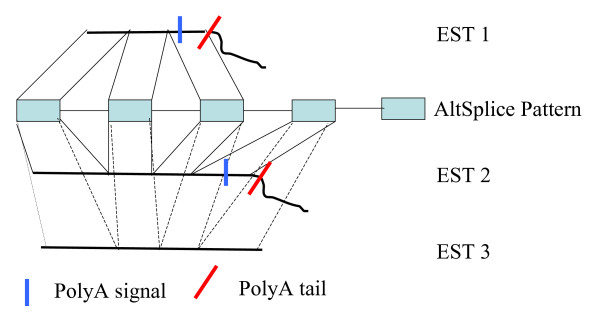
Derivation of transcript patterns by the AltTrans pipeline from AltSplice splice patterns. Each of the gene-transcript alignments from AltSplice is examined for the following: (i) the alignment shows a 3' dangling end on the EST/mRNA; (ii) such a dangling end shows a polyA tail sequence; and (iii) a polyA signal is seen on the gene within a maximum distance of 40 nts 5' to the cleavage position. Transcripts that show these features are grouped in a manner that each class of transcripts possesses the same exon/intron organisation and the same terminating polyA site. Such derived alternate transcript patterns are described as AltTrans transcript patterns. Note: Of the three EST's, that are all grouped under one AltSplice splice pattern, the EST3 does not show a "dangling end" and hence it is not considered further in the construction of AltTrans Transcript Patterns. EST1 and EST2 form two distinct transcript patterns that differ in terminating polyA sites.